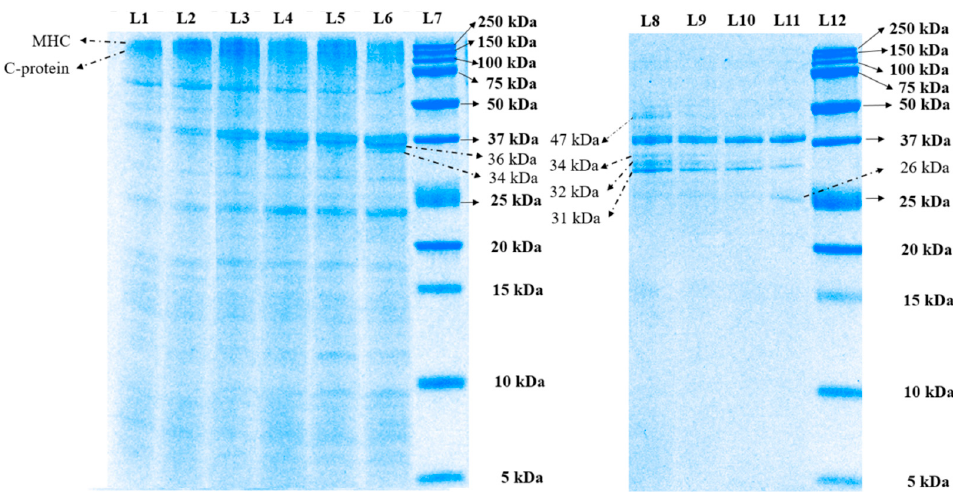
Figure 2. Tricine SDS-PAGE electrophoretogram displaying the protein profile of the digests of control sous vide (SV)-cooked and pulsed electric field (PEF)-treated SV-cooked meat during simulated digestion. L7 and L12 are the molecular weight standard, labelled in kDa. L1, L3 and L5 denote control SV-cooked samples at 2, 32 and 62 min of oral–gastric digestion, respectively. L2, L4 and L6 denote PEF-treated SV-cooked samples at 2, 32 and 62 min of oral–gastric digestion, respectively. L8 and L10 represent control SV-cooked samples at 122 and 182 min of oral–gastric–small intestinal digestion, respectively. L9 and L11 represent PEF-treated SV-cooked samples at 122 and 182 min of oral–gastric–small intestinal digestion, respectively. The protein bands were identified on the electrophoretogram as described by Kaur et al. [19,24] and Boland et al. [20]. MHC stands for myosin heavy chain.